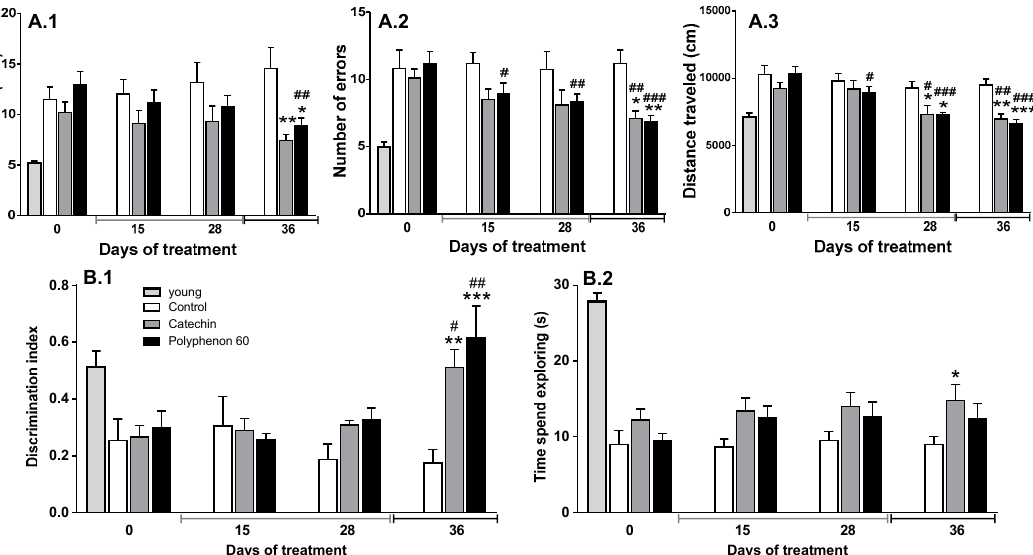
Figure 1. Evolution of spatial working memory and episodic memory of old rats (18 months) assessed during the chronic polyphenon-60 and catechin treatments. ( A ) Spatial working memory analysis through radial test. Bars represent the mean ± SEM of: time spent to complete the test in minutes (A.1), number of errors committed during the tests (A.2), and distance travelled during the tests in cm (A.3). ( B ) Episodic memory analysis through novel object recognition test. Bars represent the mean ± SEM of: discrimination index during tests (B.1), calculated by subtracting the time (in seconds) exploring the familiar object with respect to the time exploring the novel one and dividing by the total time exploring any object; and total time spend exploring both equal objects during familiarizing phase (in seconds, B.2). Animals were treated with catechin ( n = 5; dark grey bars) or polyphenon-60 ( n = 6; black bars) (20 mg/kg, i.p., for 28 days; followed by 40 mg/kg, i.p., during 7 additional days; both treatments). Control animals received 1 mL/kg of corn oil for 40 days (i.p.; n = 6; white bars). Young animal group (light grey bar) was used as reference to compare with old animals ( n = 6). Two-way ANOVA followed by Bonferroni post-hoc test was used for statistical analysis. * p < 0.05, ** p < 0.01, *** p < 0.001 when comparing treated groups with control group at the same time point. # p < 0.05, ## p < 0.01, ### p < 0.001, when comparing data within each experimental group with respect to the initial data. Young animals were significantly different from all old rat groups when compared with the chronic treatments start for all parameters analyzed (one-way ANOVA followed by Bonferroni post-hoc test, p < 0.05 at least; comparison not indicated in the graph).